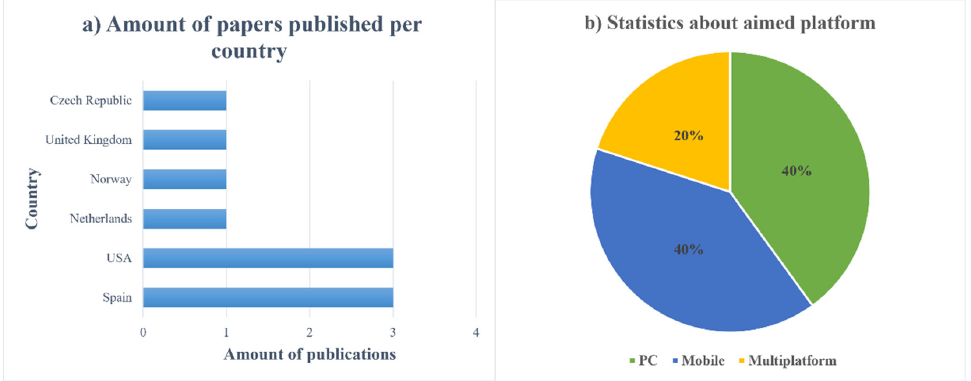
Figure 3. Results of the review of Tables 6 and 7: ( a ) amount of papers published per country; ( b ) aimed platform statistics.